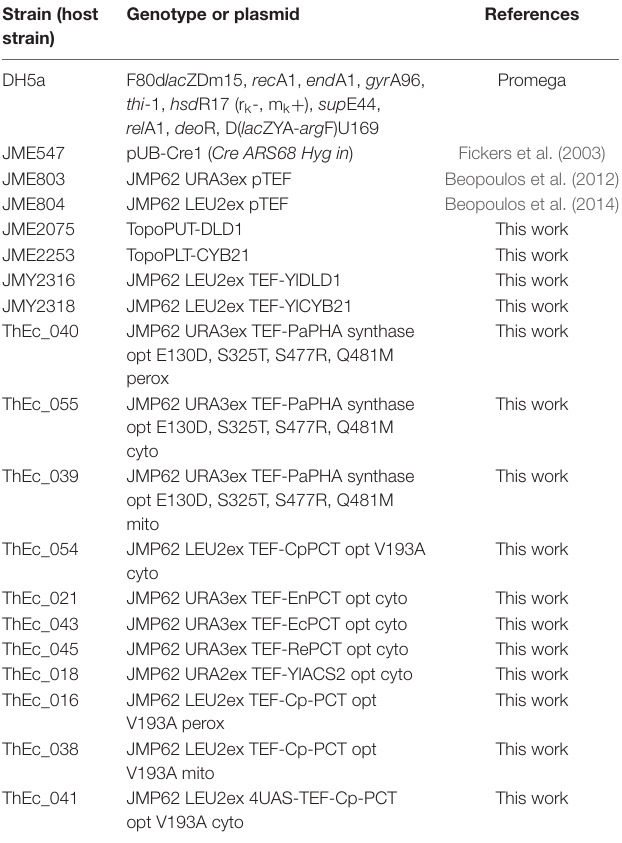
TABLE 1 | E. coli strains and